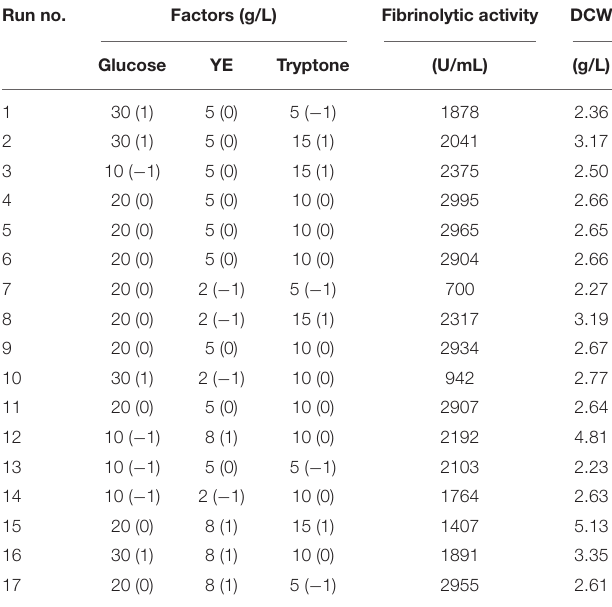
TABLE 1 | Design and results of